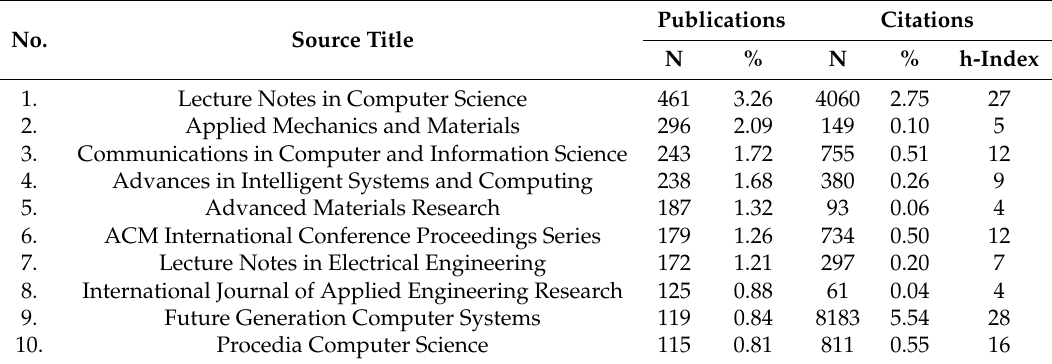
Table 3. Top most productive source titles in research on cloud